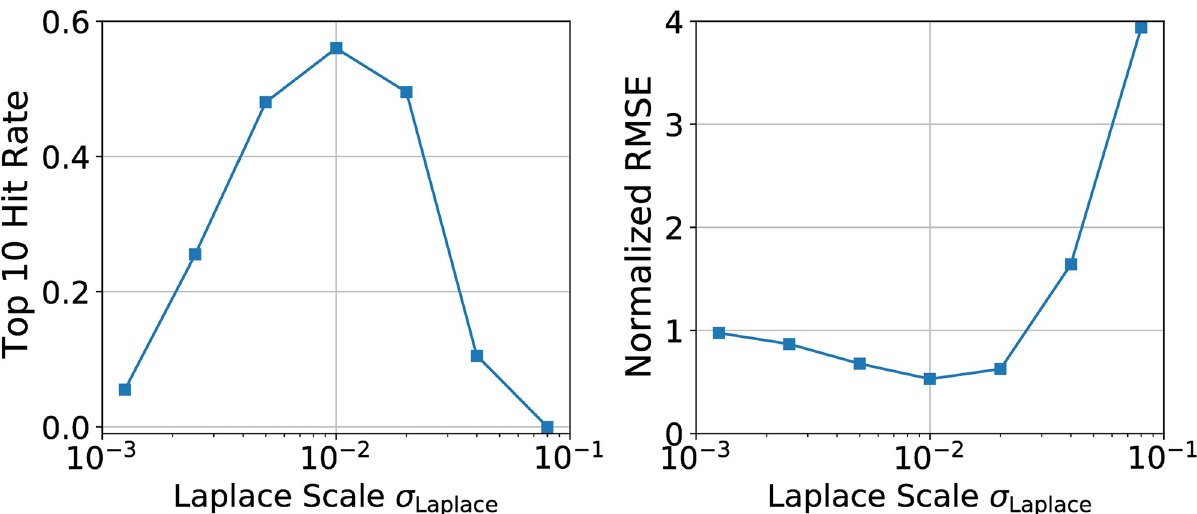
Fig 3. Sensitivity to the Laplace regularization scale. We explore the sensitivity of the Laplace method to the prior scale σ Laplace . Changing σ Laplace from the optimal value of σ Laplace � 0.01 results in significantly worse performance. We consider A = 3000 alleles and N simulated